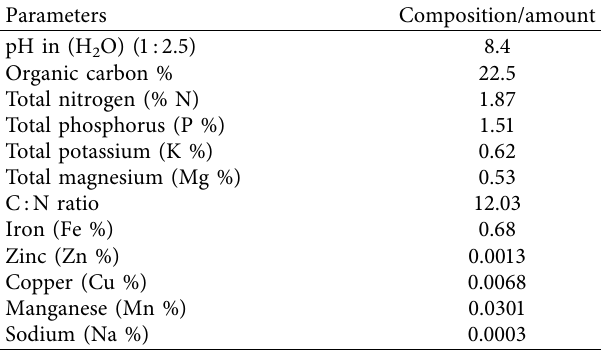
Table 5: Chemical properties of goat manure used for the